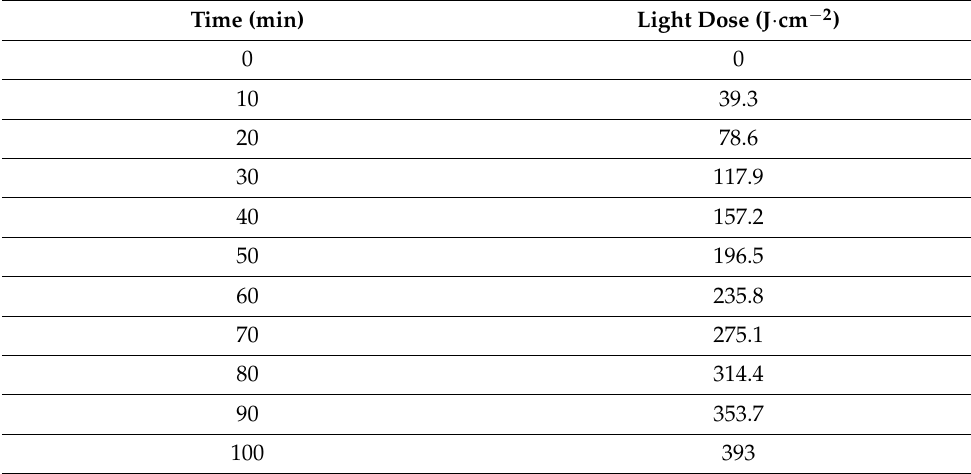
Table 4. Light dose applied in the nanocomposites.